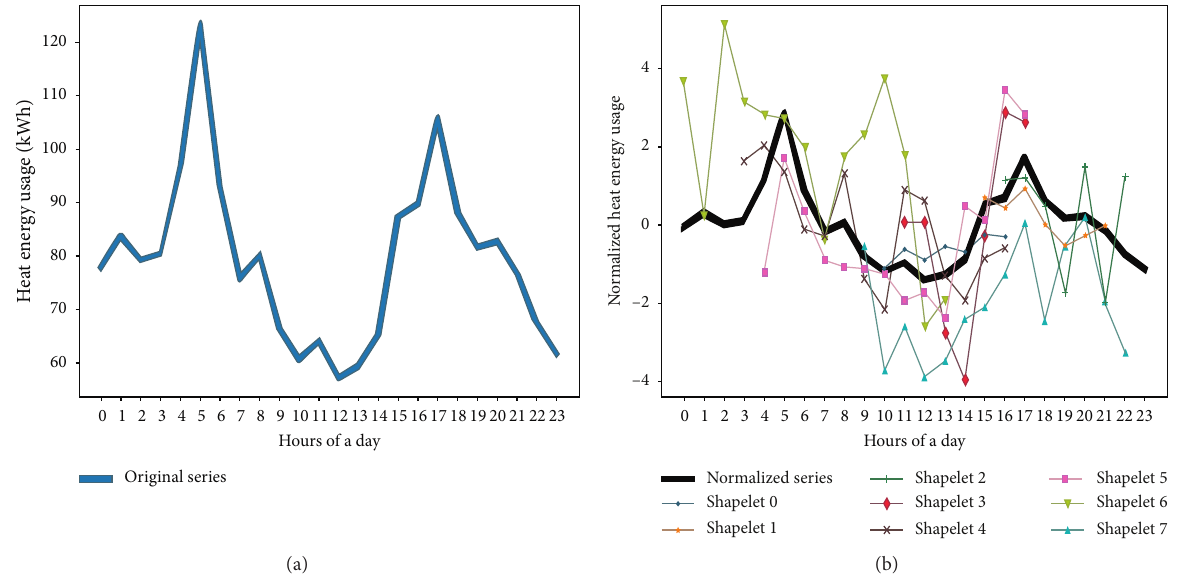
Figure 4: Sample case three (nonnight setback, multifamily hot water profile): morning peak at 5 a.m. and evening dip at 5 p.m.